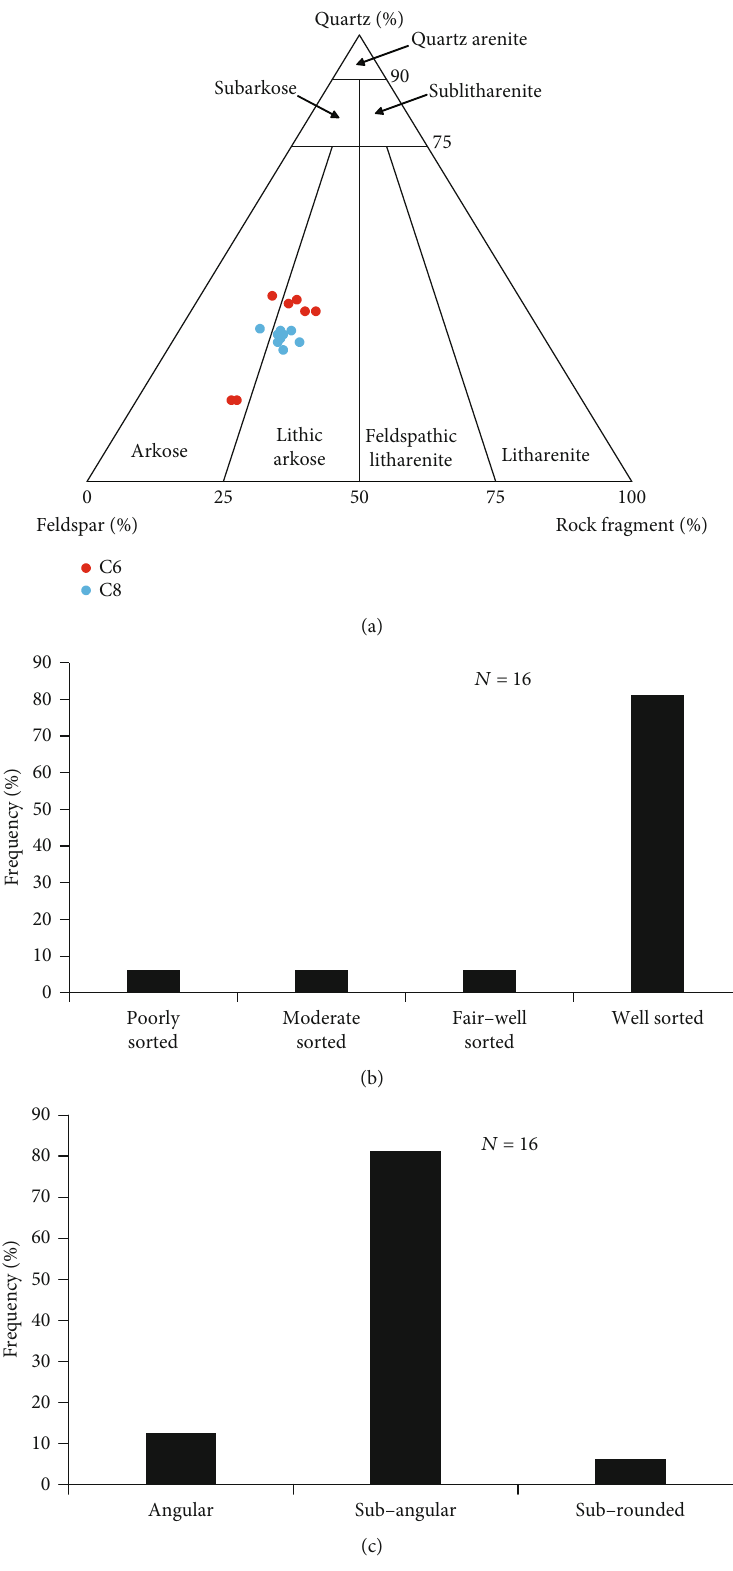
Figure 2: Petrographic characteristics of tight sandstone reservoirs in Ordos Basin. (a) Classi fi cation of tight sandstones on a basis of Folk ’ s methods [29]; (b) sorting distribution; (c) roundness